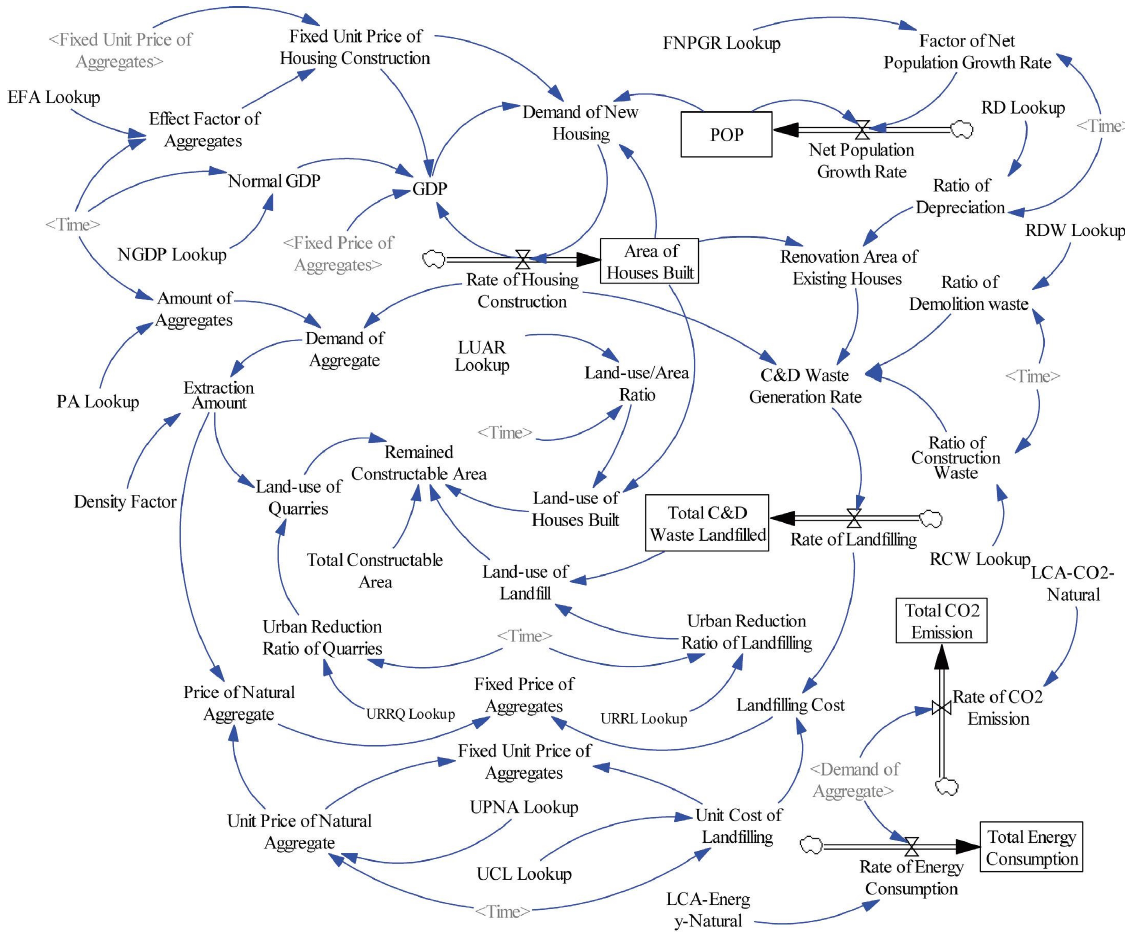
Figure 3: Chart of stock-fow of C&D waste generation in